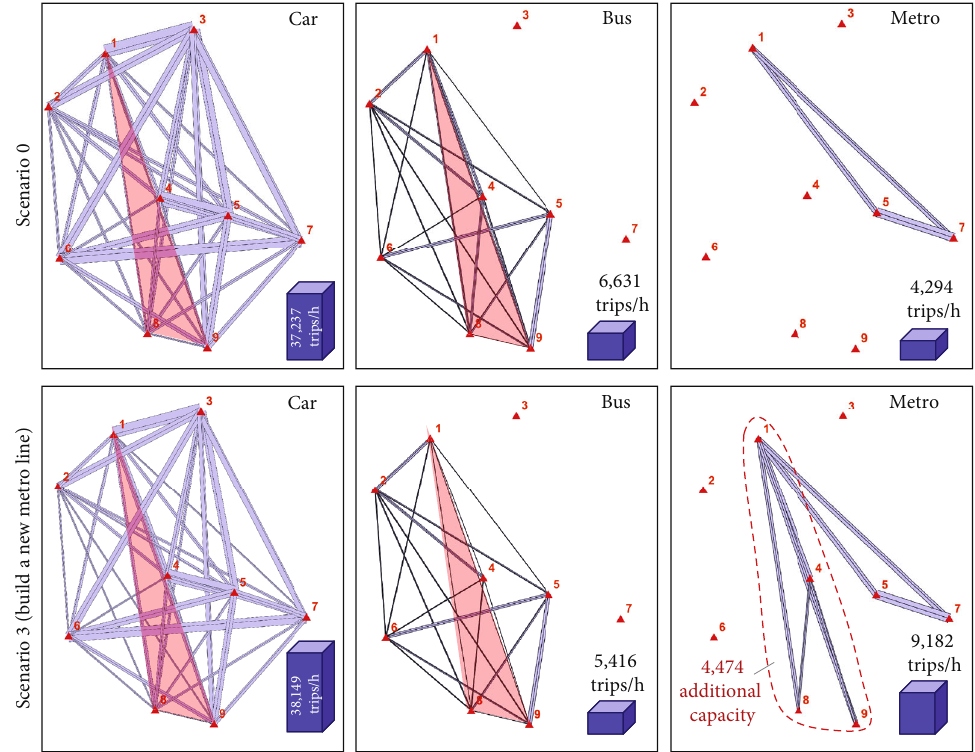
Figure 17: Maximum demand by multimodal OD before and after building new metro